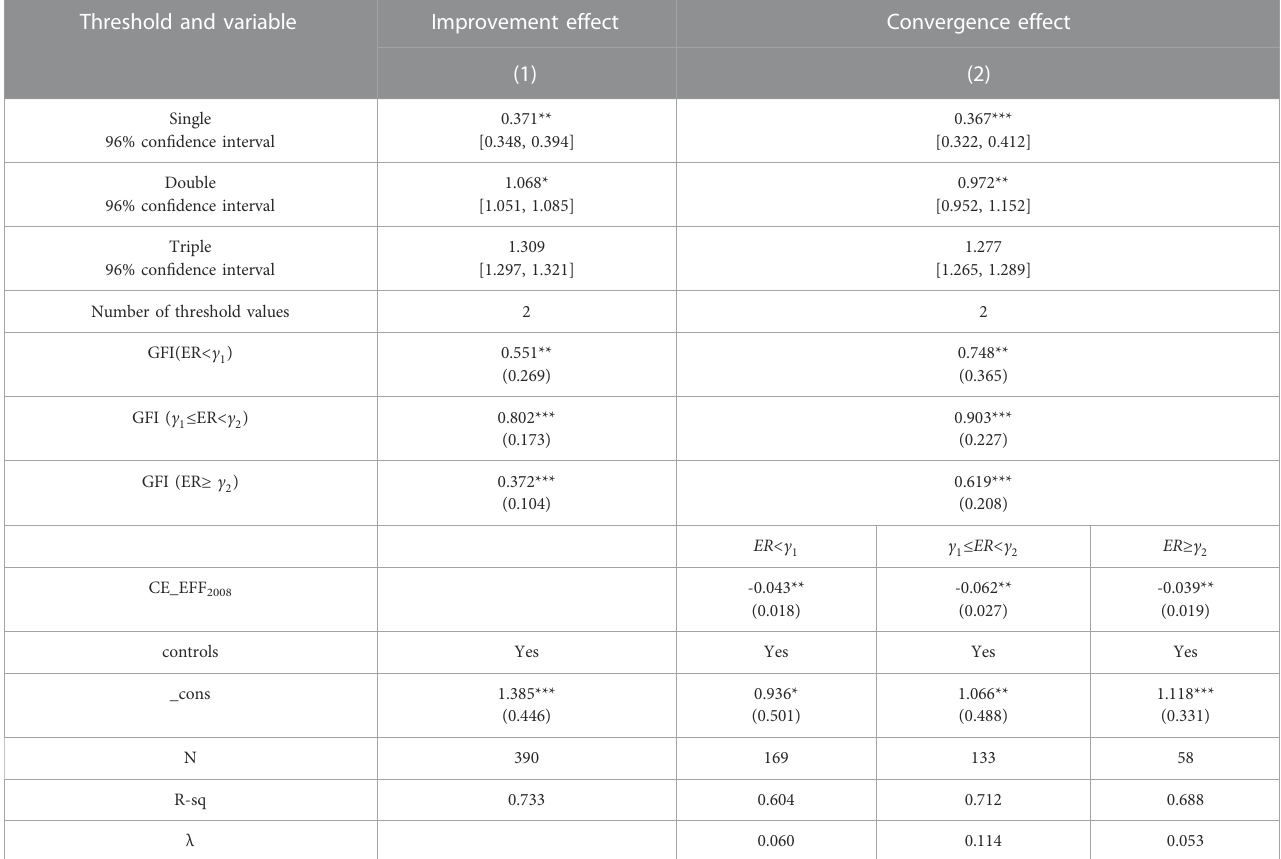
TABLE 6 Empirical results of the threshold effect of environmental regulation. Threshold and